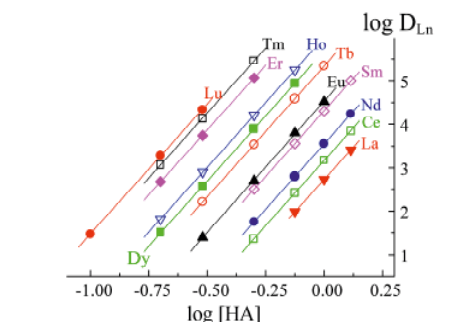
Figure 4 . The effect of D2EHPA concentration in the sorbent phase on the adsorption of Ln(III) from 0.05 M HNO solutions. The sizes of the 3 points represent error bars. Slope: 5.95 ± 0.25 (La), 6.01 ± 0.26 (Ce), 6.02 ± 0.21 (Nd), 6.04 ± 0.21 (Sm), 6.02 ± 0.23 (Eu), 6.02 ± 0.20 (Tb), 5.97 ± 0.0.26 (Dy), 5.96 ± 0.25 (Ho), 5.96 ± 0.24 (Er), 5.96 ± 0.22 (Tm), and 5.98 ± 0.21